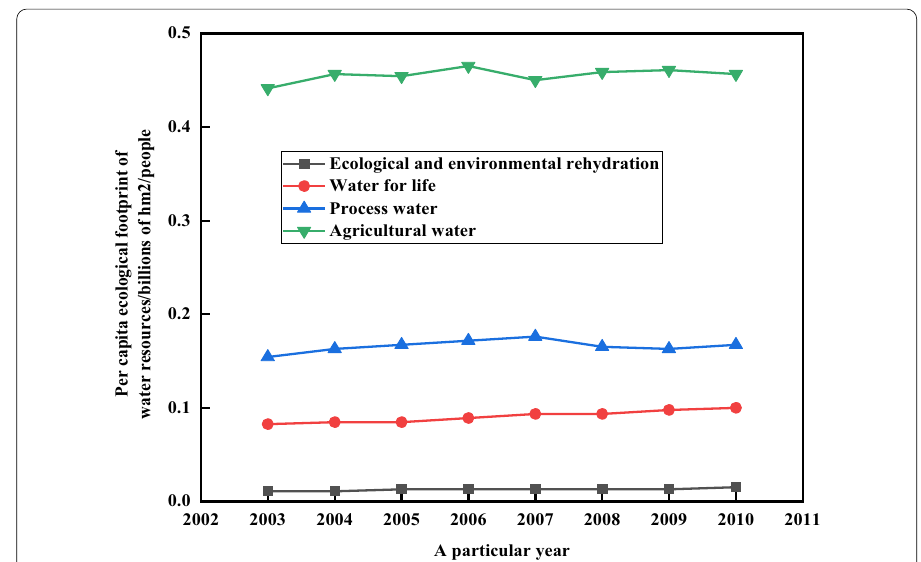
Fig. 7 Ecological footprint of water resources per capita in different production accounts in China,